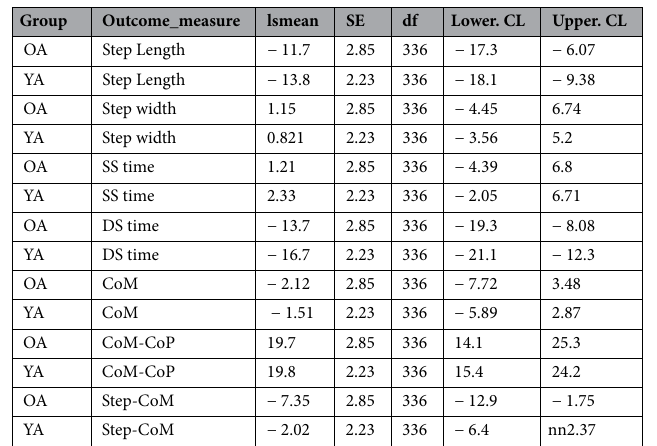
Table 7. After Magnitude posthoc comparisons: estimated 95% confidence intervals for % (cid:31) magnitude